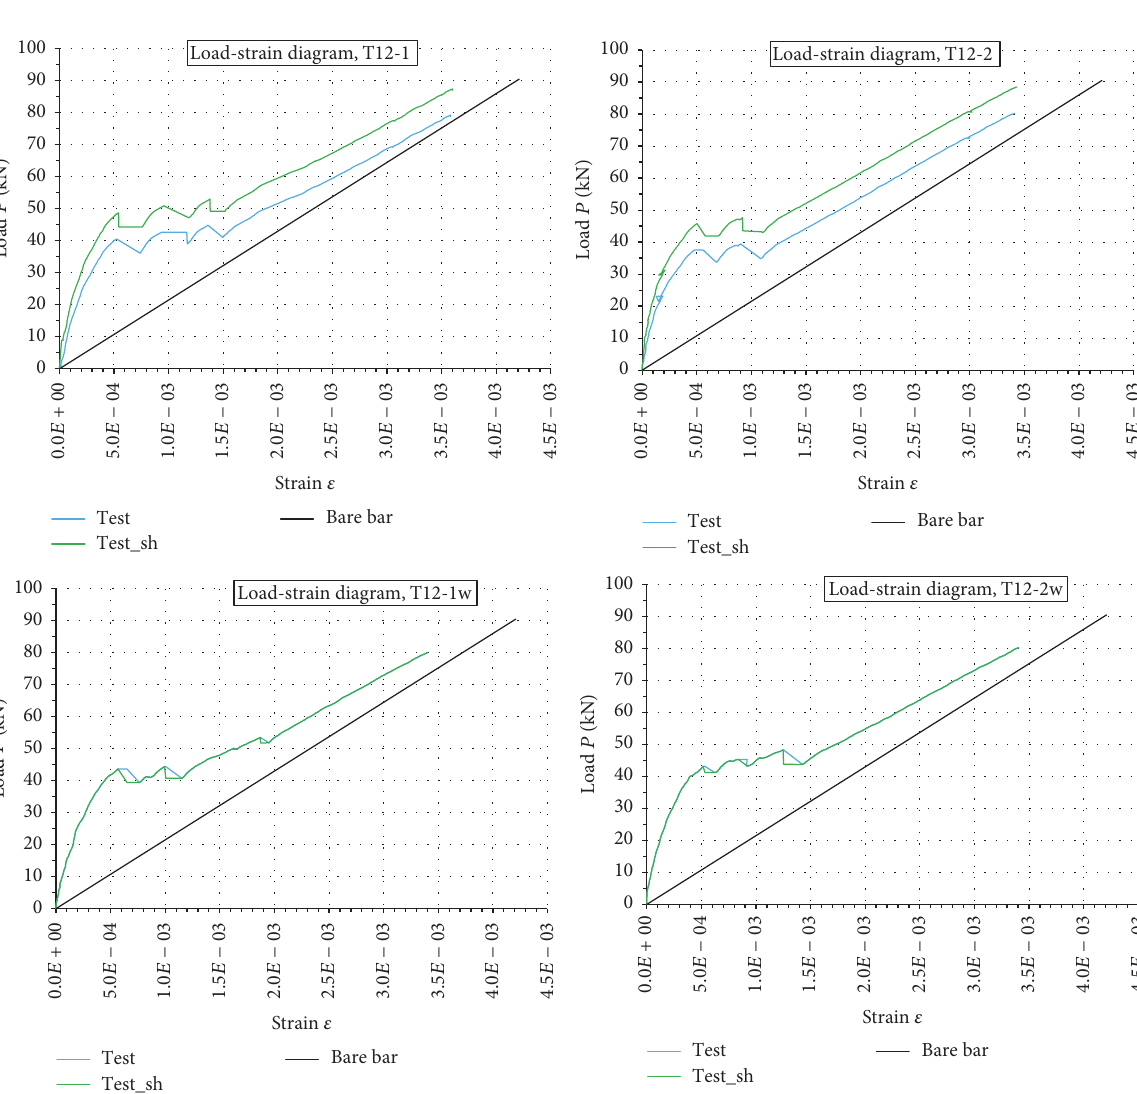
Figure 4: Experimental load-strain relation of the ties.